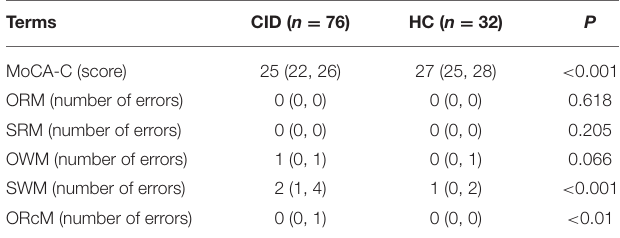
TABLE 3 | Cognitive